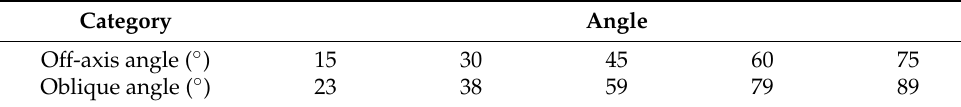
Table 2. End-tab oblique angle ϕ for different off-axis specimens.